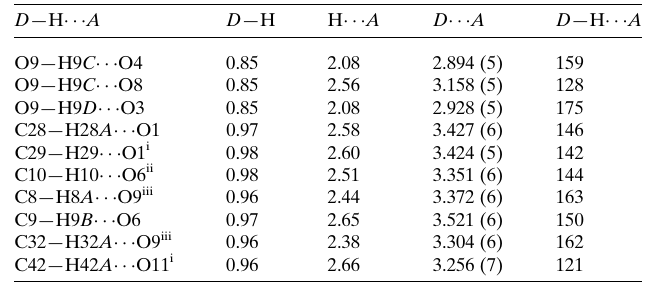
Table 2 Hydrogen-bond geometry (A˚ , (cid:5) ).